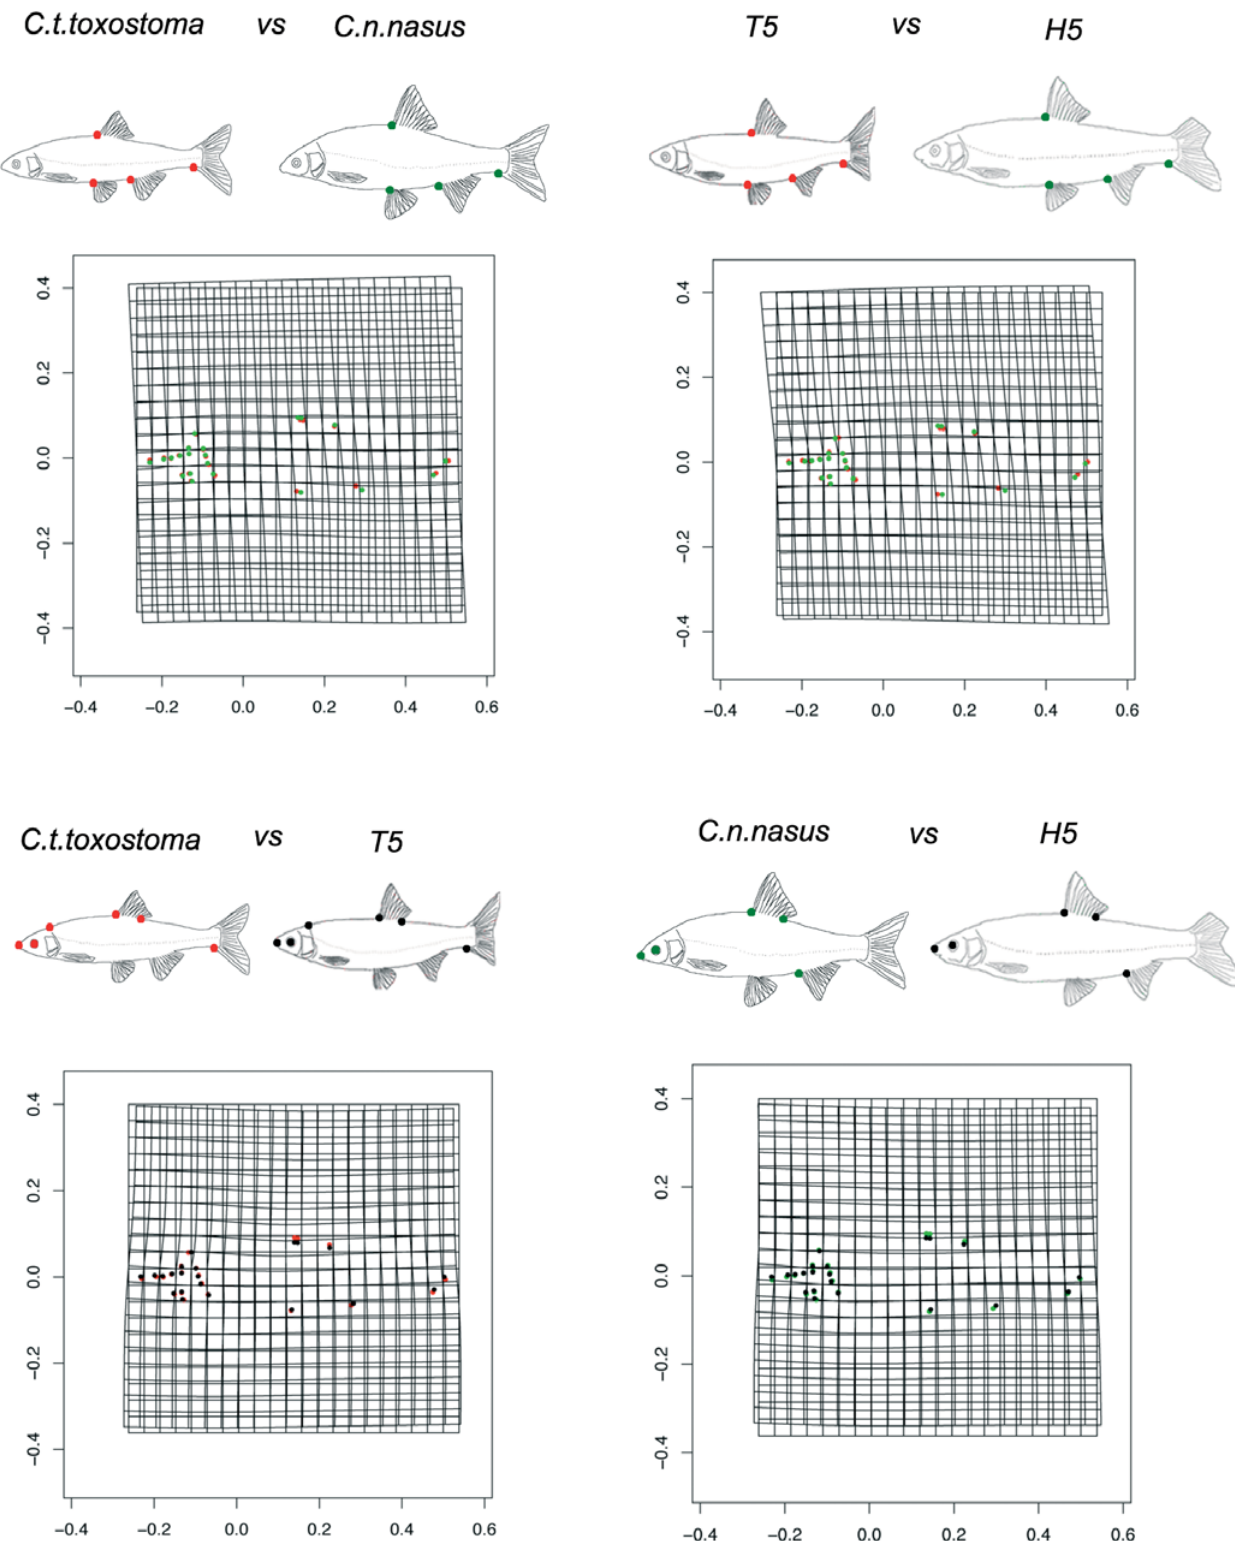
Figure 4. DEFORMATION GRIDS. Deformation grids for various ‘‘mean specimen’’ comparisons (based on the 21 landmarks). These diagrams are schematic representations of the morphology encountered in allopatric/parapatric zones or in hybrid zones. The points indicate the main deformations observed on the corresponding grid.